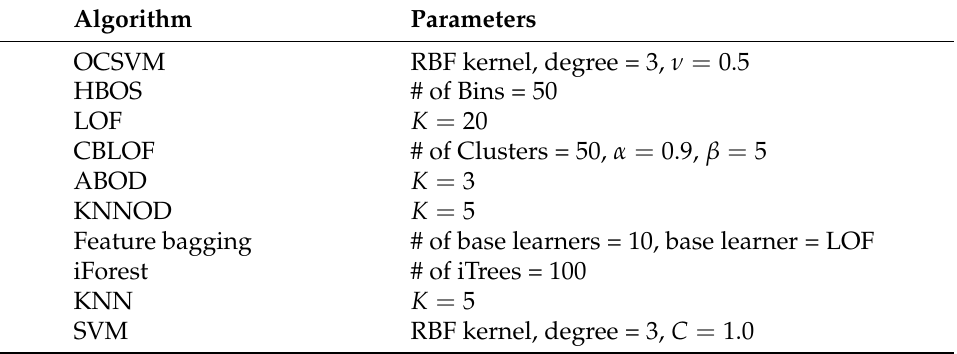
Table 3. Parameters used by the semi-supervised and supervised algorithms investigated in our